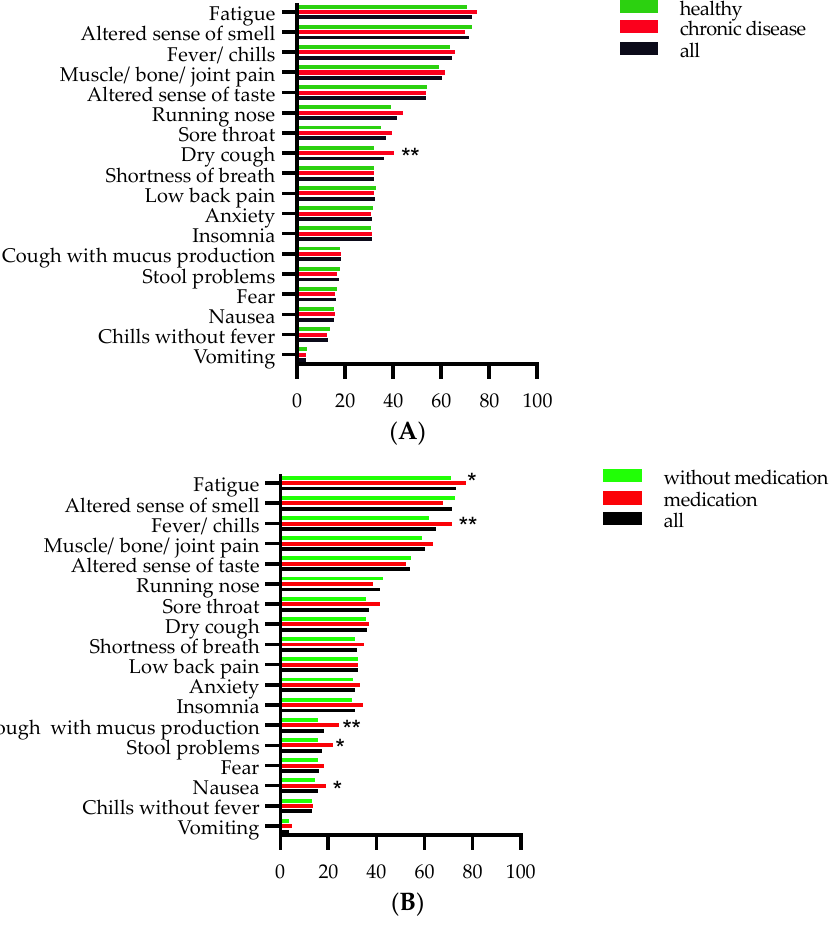
Figure 1. Acute symptoms in 1050 participants. Panel ( A ) presents percentages of healthy participants (green) and with chronic disease (red) reporting any acute symptoms prior to acute infection. Panel ( B ) presents percentages of participants without (green) and with medication (red) prior to acute infection. Statistically significant differences are indicated between healthy and with chronic disease (panel ( A )) and between participants with and without medication (panel ( B )) prior to acute infection. * p < 0.05 and ** p < 0.01 (Chi-square test).